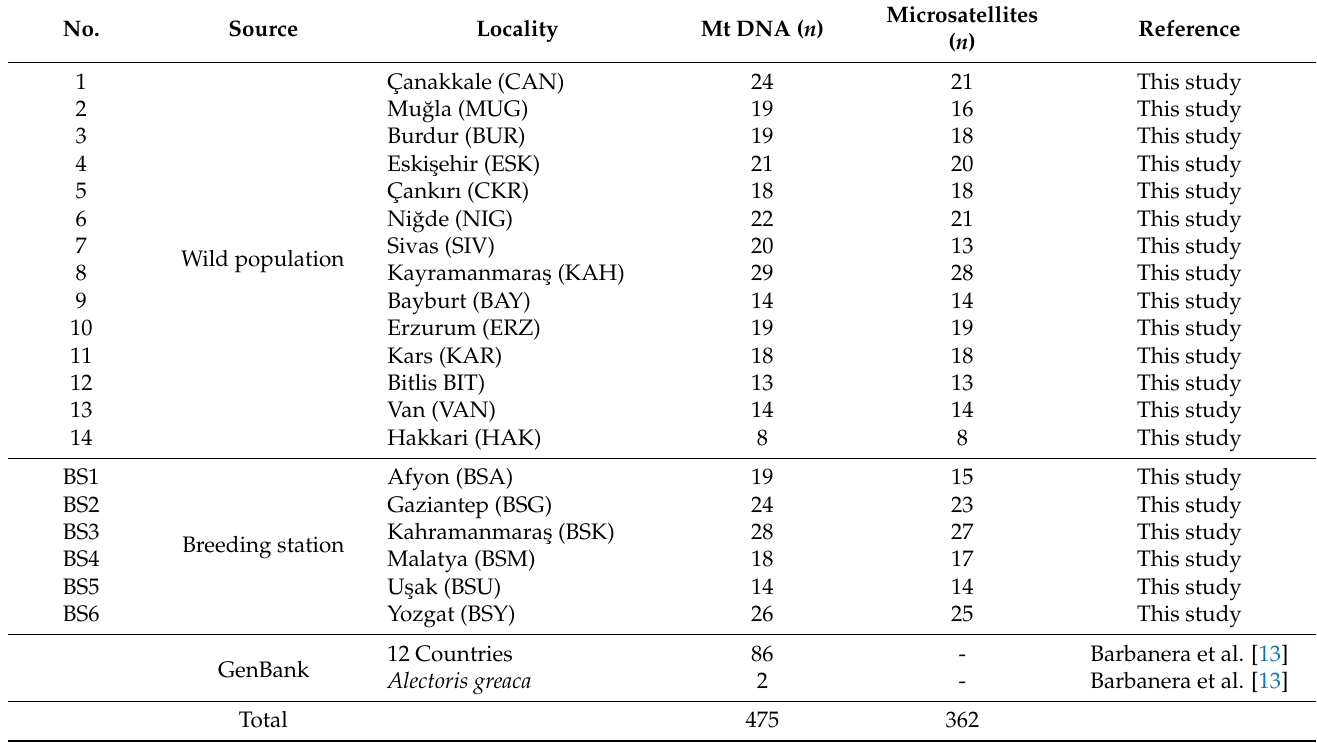
Table 1. Chukar Partridge sampling locations and sample size. Abbreviations for each wild and captive population surveyed in this study are spelled